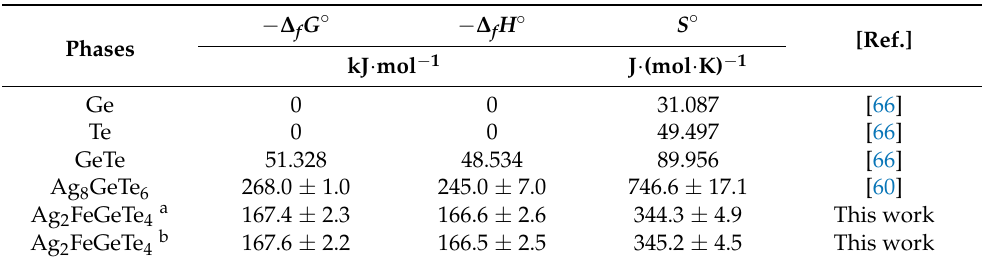
Table 8. The Standard thermodynamic quantities of the selected elements and compounds in the Ag–Fe–Ge–Te system at 298